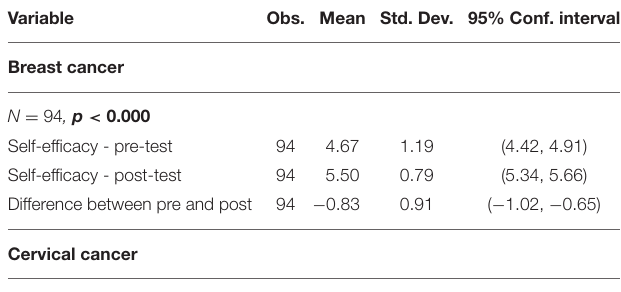
TABLE 2 | Psychosocial determinants and control variables of Promotores . Independent variables